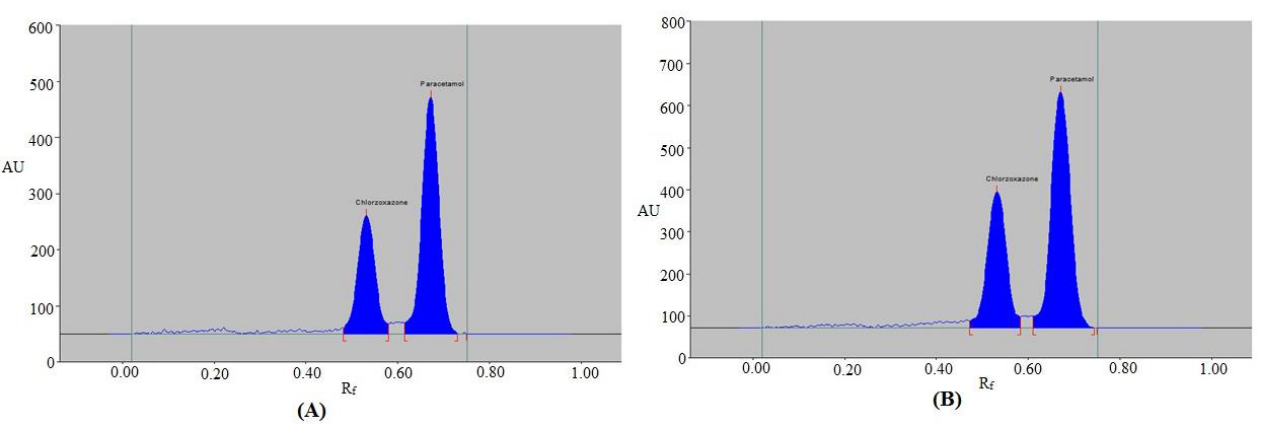
Figure 4. HPTLC-UV densitograms of CZN and PCT in ( A ) marketed Relaxon capsules and ( B ) marketed Myodol tablets.